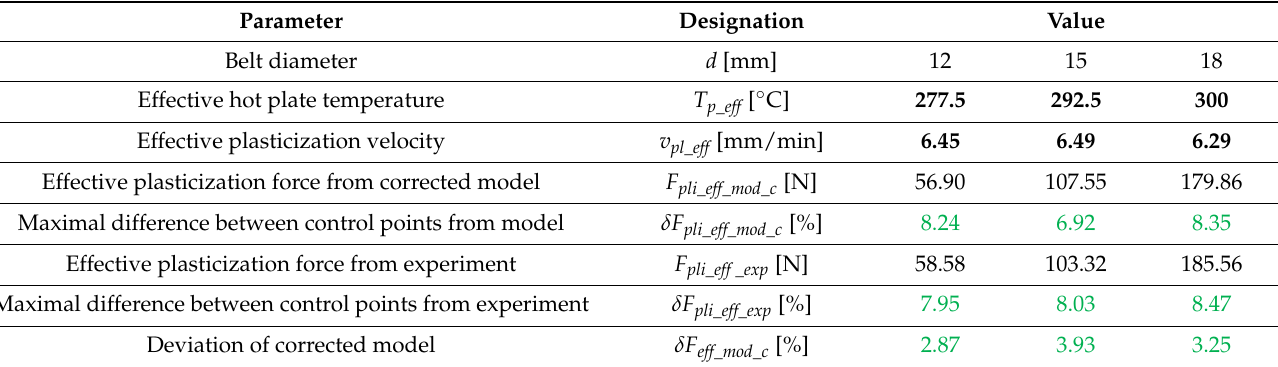
Table 3. The results of the NCGA optimization for three analyzed diameters of the